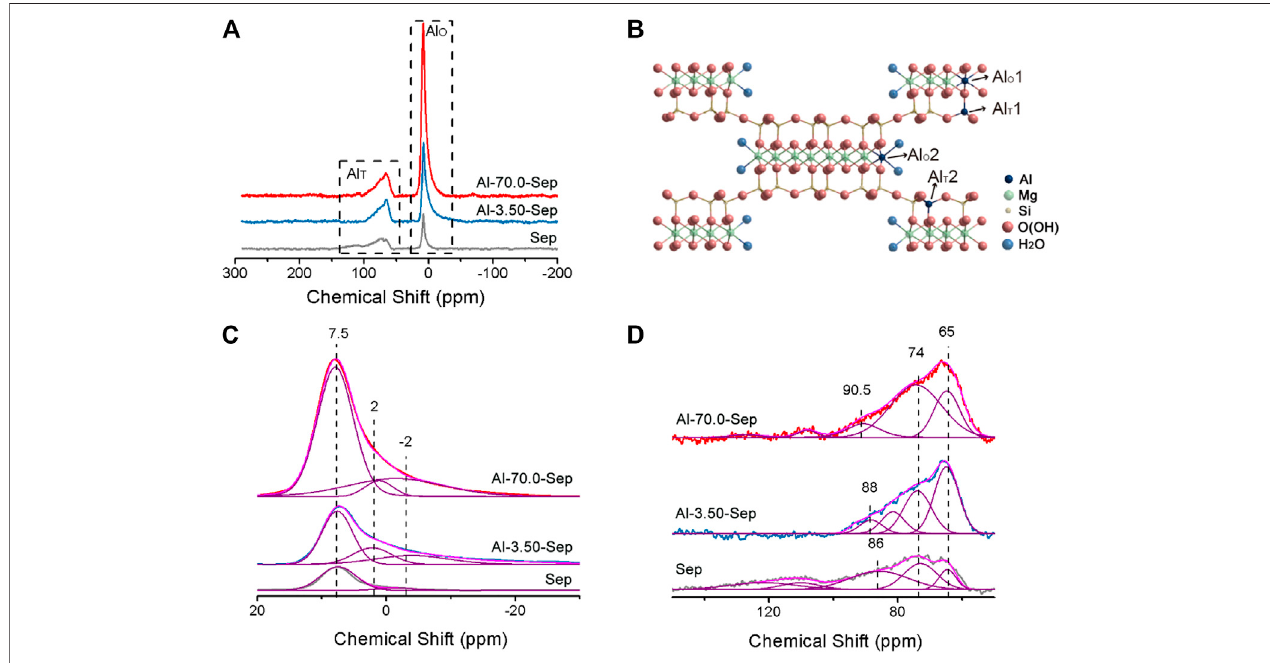
FIGURE4 |(A) 27 AlNMR spectra ofSep, Al-3.50-Sep, and Al-70.0-Sep. (B) Schematic diagram of thepositionofAl T and Al O in sepiolite. The simulated results of ( A ) (C) at 20 ∼ -30 ppm and (D) at 150 ∼ 50 ppm.